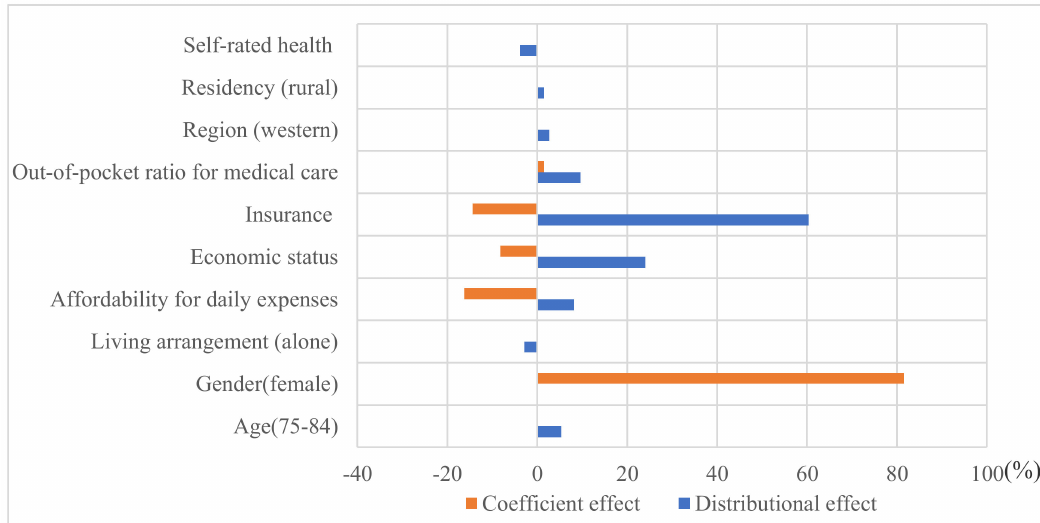
Figure 1. Percentages of distributional and coe ffi cient contributions to the change in perceived accessibility to healthcare between 2005 to